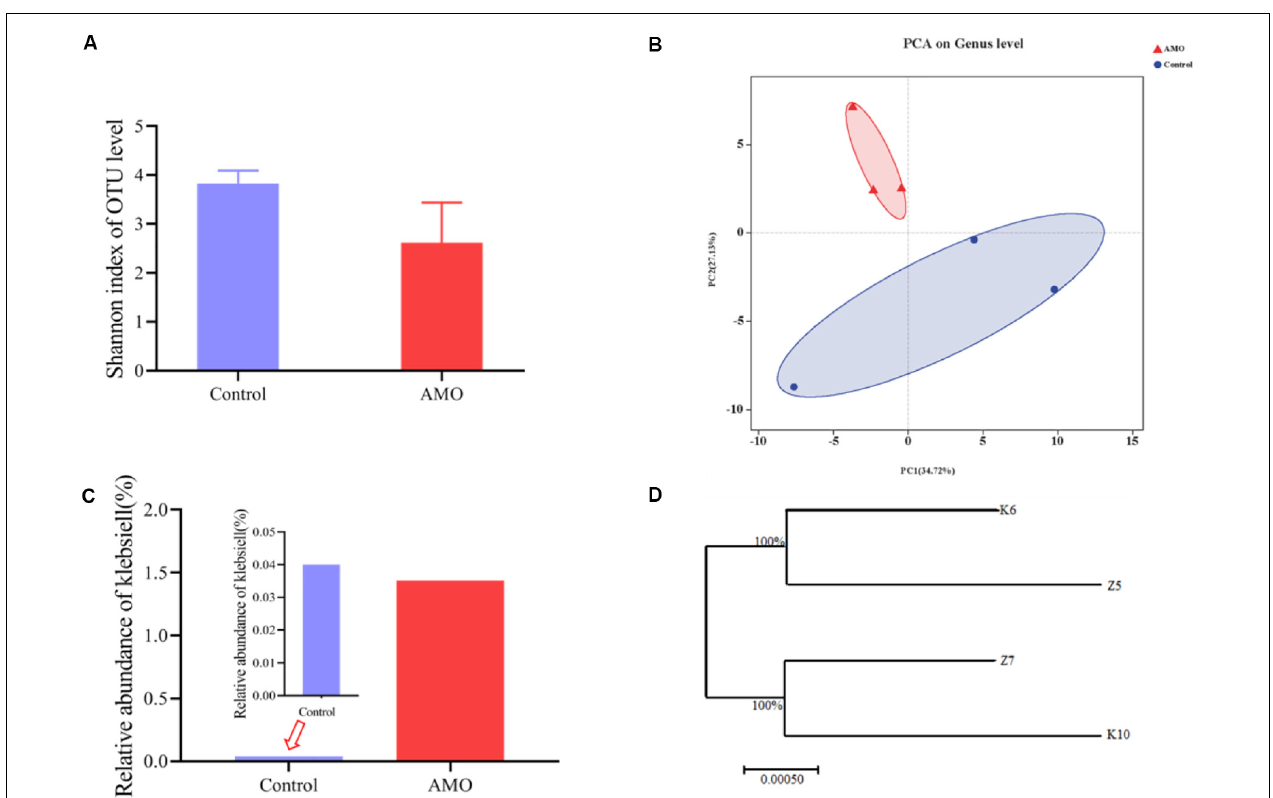
FIGURE 1 | Effect of AMO on the mouse gut microbial community. (A) Diversity of microbiota after AMO treatment, assessed by Shannon index. (B) PCA plot based on the genus level between the AMO and control groups. (C) Relative percentage of Klebsiella between the AMO and control groups. (D) Cladogram of 4 representative Klebsiella isolated from AMO and control based on the full-length 16S rRNA gene sequencing results. Data presented as means ± SD ( n = 3), difference at significance level * P < 0.05 ( t -test) between two